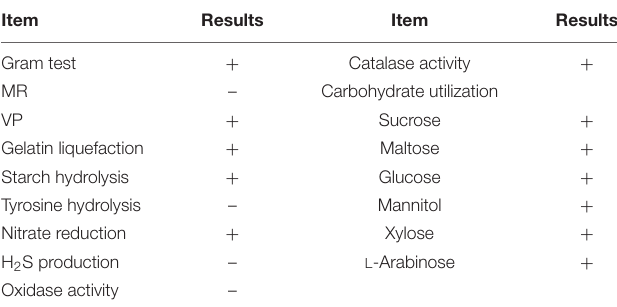
TABLE 1 | Biochemical and physiological characteristics of B. amyloliquefaciens B2.